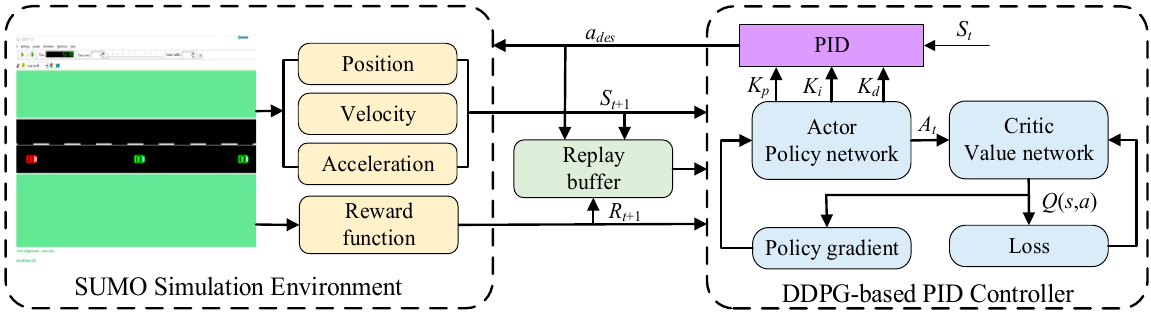
Figure 4. The framework of the training platform.